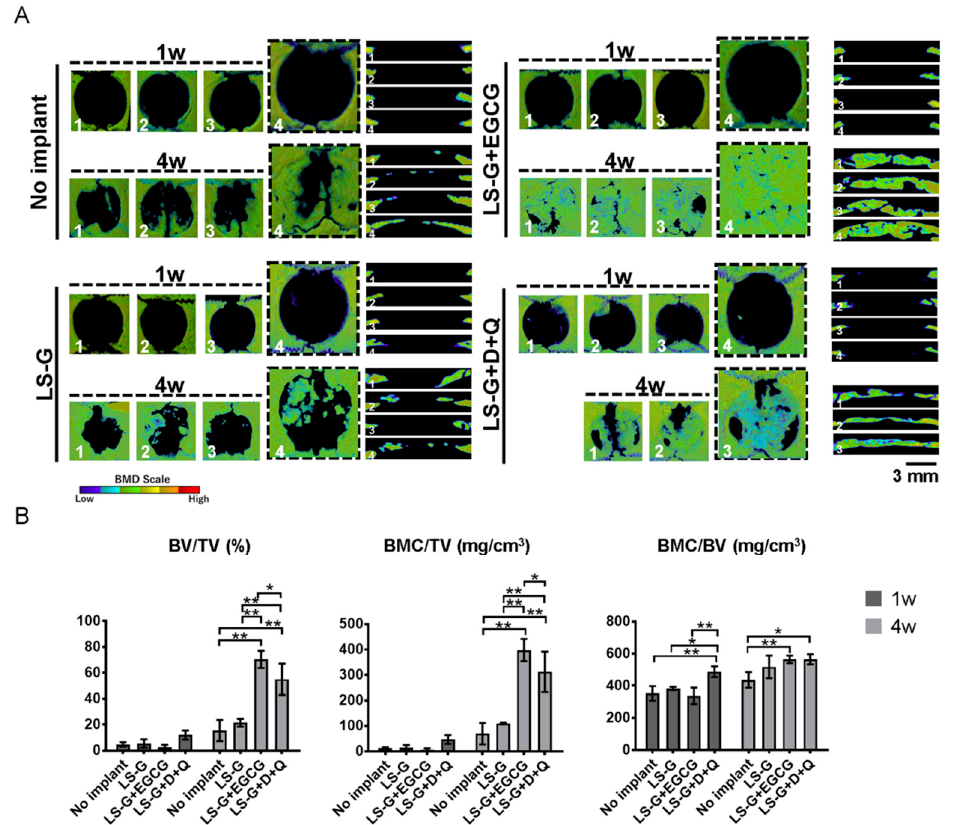
Figure 6. Histomorphometric analysis using microcomputed tomography ( µ CT). ( A ) Vertical and lateral views of bone mineral density images of bone defects one or four weeks after surgery. Four defects were analyzed in each group. One rat treated with LS-G + D + Q for four weeks unexpectedly died at three weeks during the experimental period. ( B ) Morphometric analysis using µ CT. BV, bone volume; TV, total volume; BMC, bone mineral content; D, Dasatinib; Q, Quercetin; LS-G, implantation